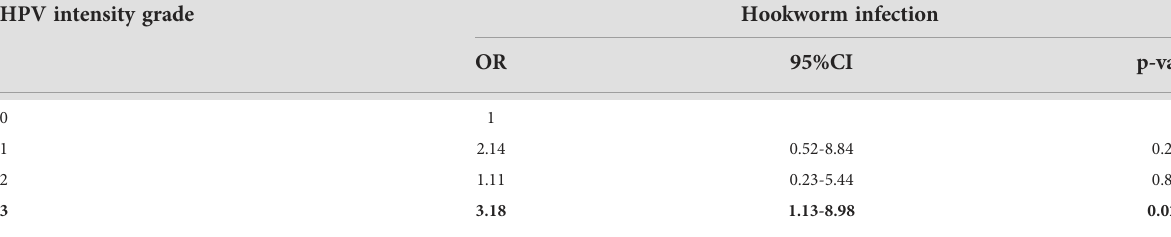
Bold values indicates signi fi cant